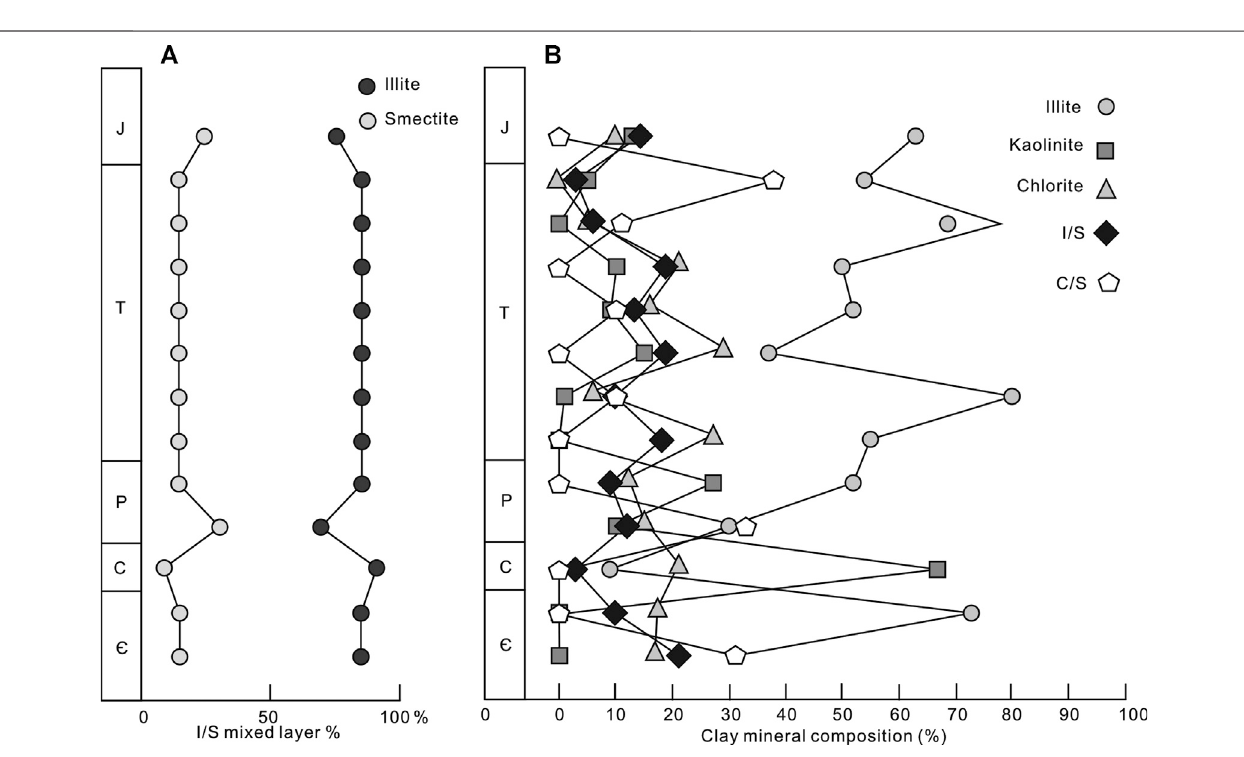
Frontiers in Earth Science |